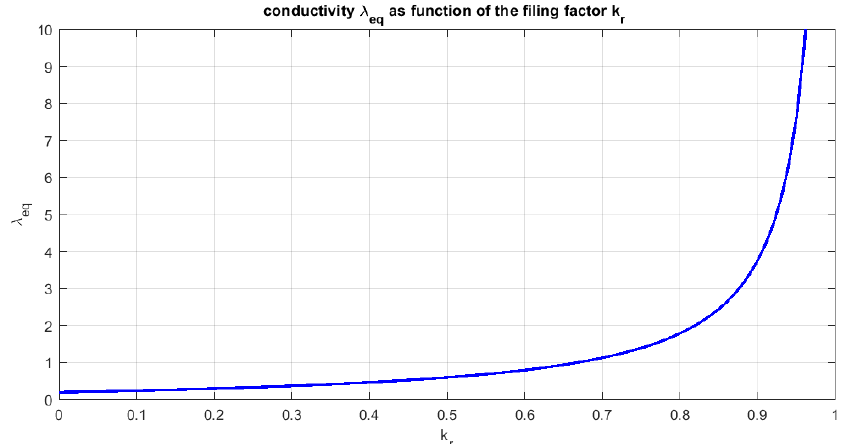
Figure 6. Variation of the equivalent conductivity of the homogenate medium as a function of the filling factor k r